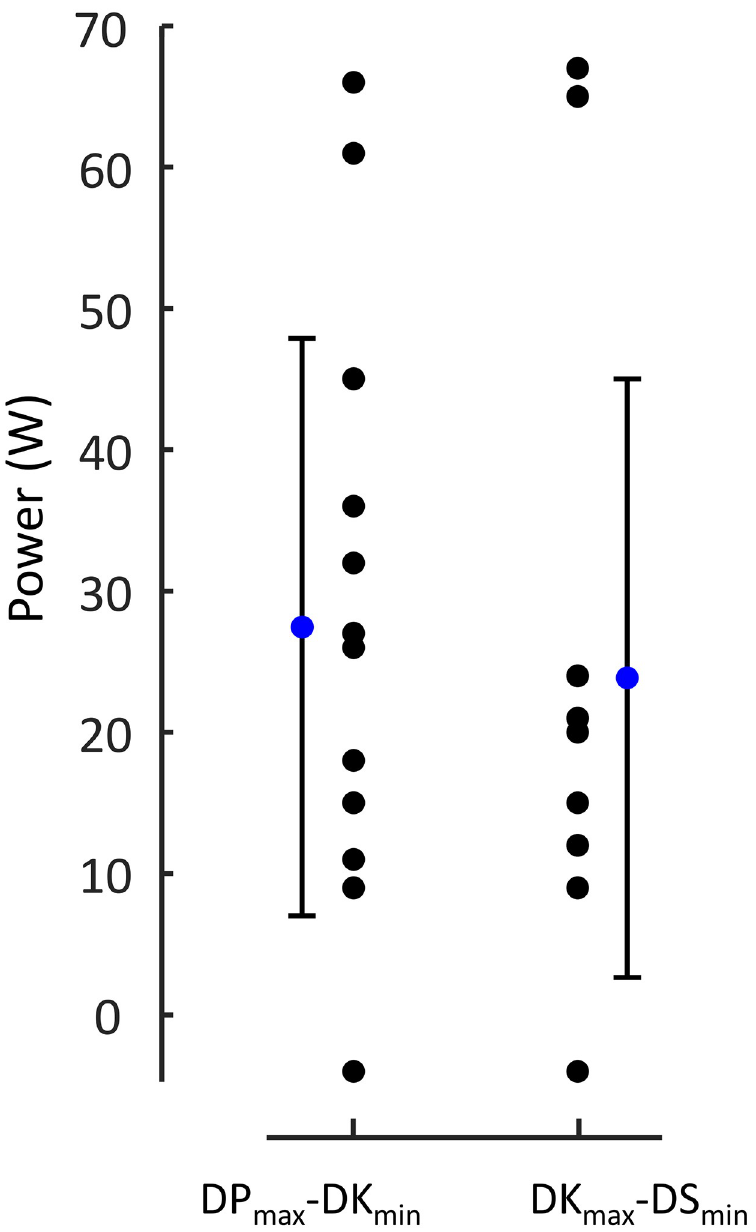
Fig 2. Mean, SD and individual values of overlap of power distribution for the three techniques. Differences between maximal and minimal power for ‘adjacent’ techniques are shown (irrespective of which session these were